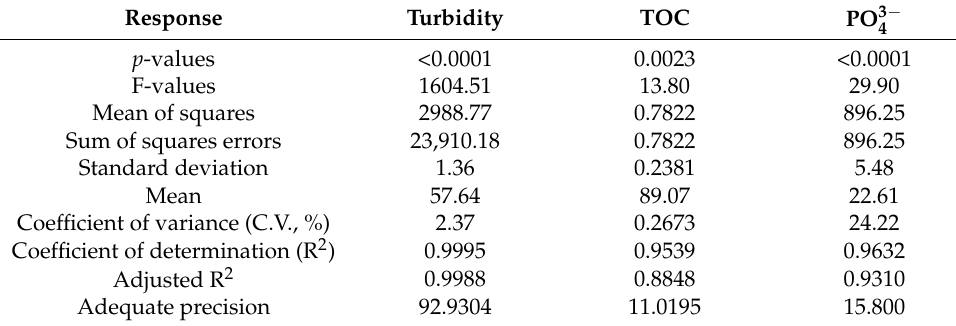
Table 4. ANOVA statistical results for response